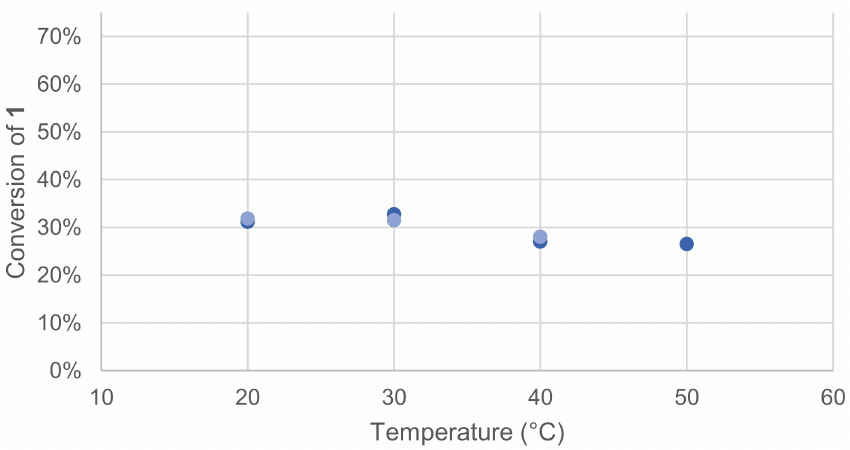
Figure 3. Effect of temperature on the conversion of 1 in the laccase-catalyzed oxidation (LA 10% w/w , HOBt 20 mol%, acetate buffer pH5 0.25 M, O 2 atmosphere, incubation for 24 h, 200 rpm). Reactions run in